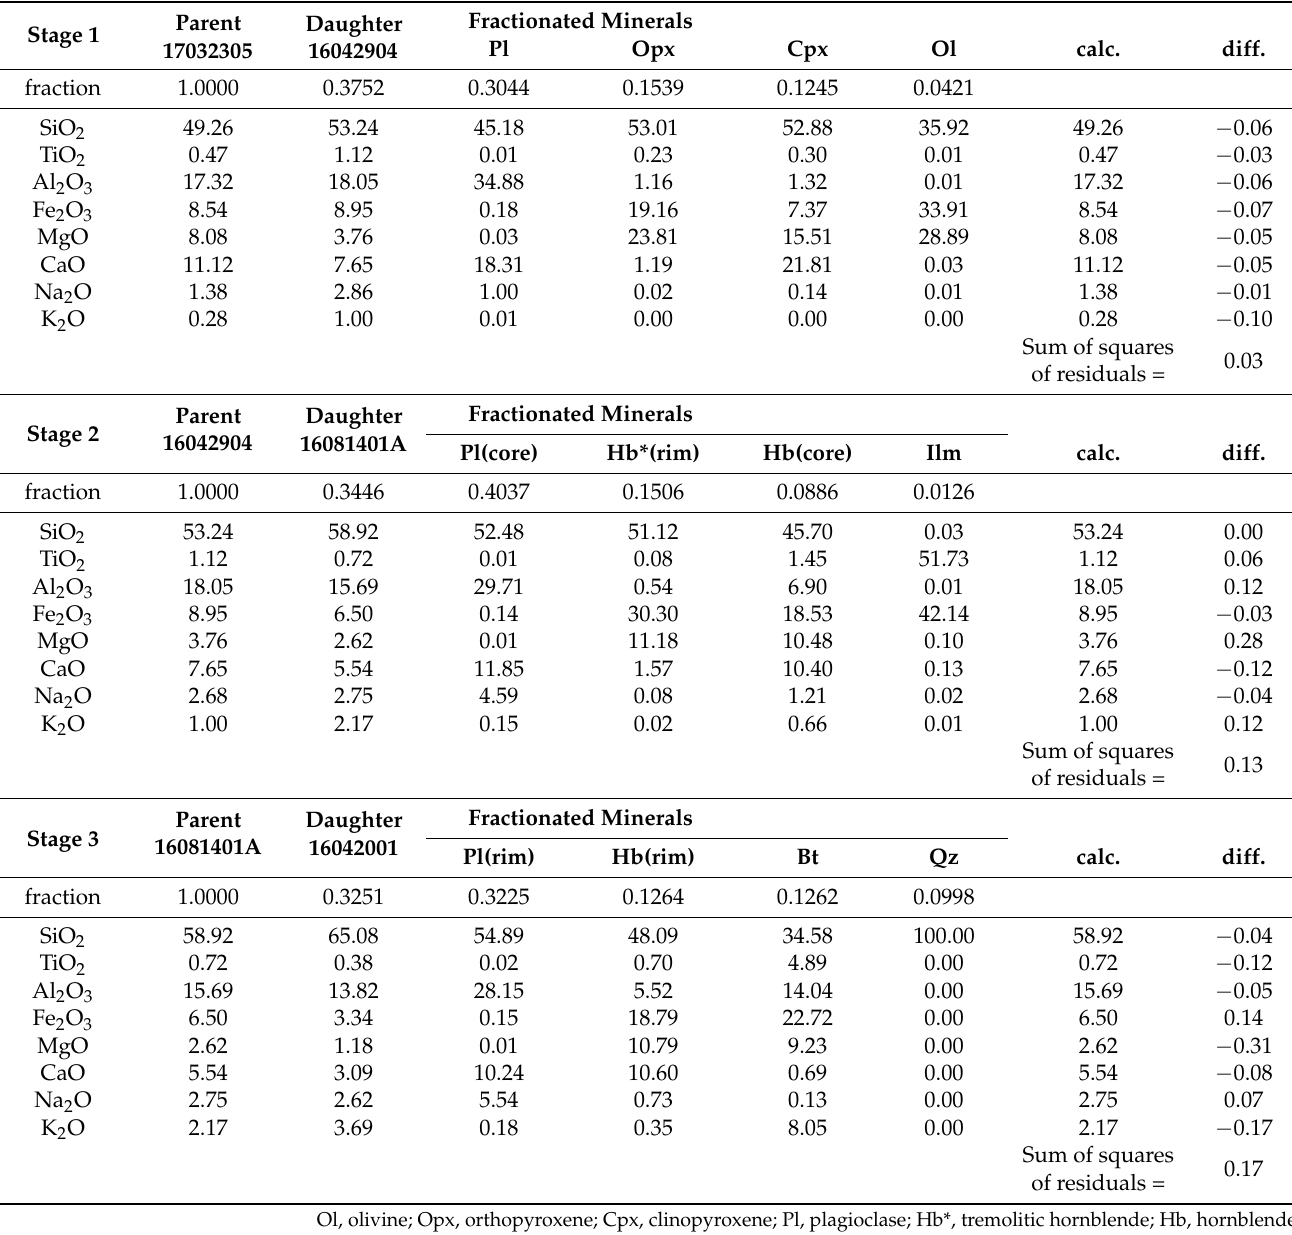
Table 2. Results of mass balance calculation using the whole-rock and mineral compositions for Fn-gabbro and the